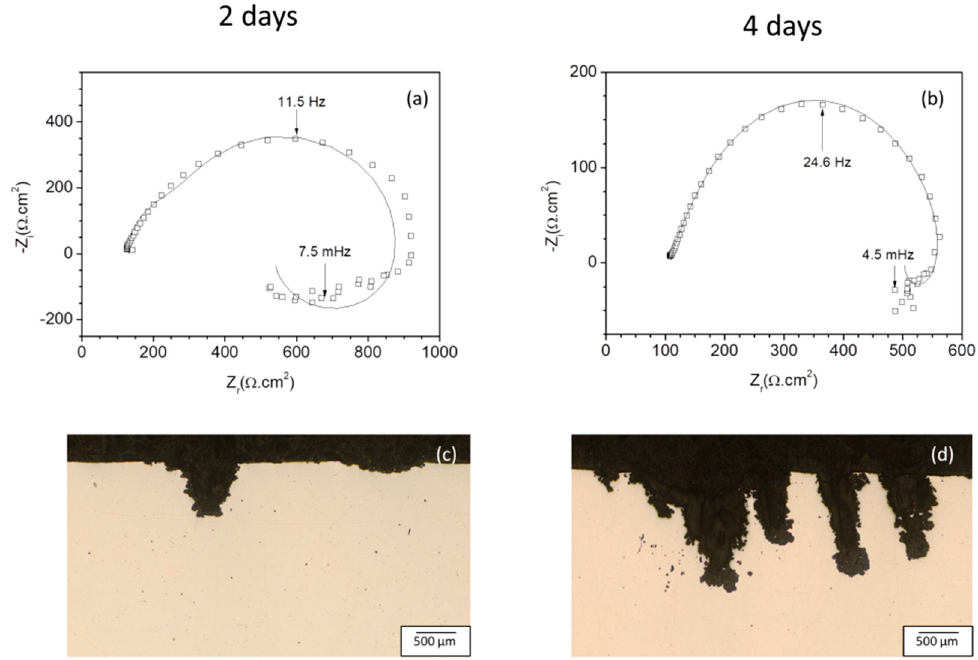
Figure 10. Comparison between electrochemical impedance spectra obtained from AZ31B exposed in Ringer ′ s solution (37 °C) for 2 and 4 days ( a – b ) and optical cross-sectional images of samples tested under similar conditions ( c – d ).